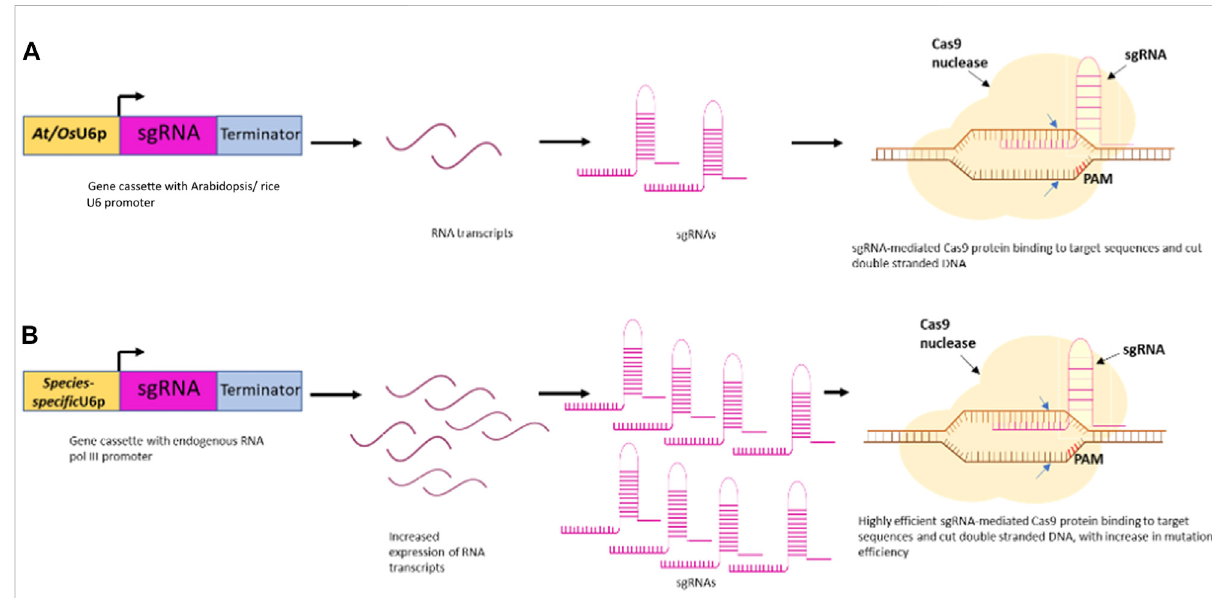
Schematic illustration of RNA Polymerase III promoter facilitating high-ef fi ciency CRISPR/Cas9-mediated plant genome editing. (A) sgRNA expressionunder At/OsU6 promoterinplant (B) sgRNAexpressionunderspecies-speci fi cpromoterinplantleadstoincreasedexpressionandhigher gene editing ef fi